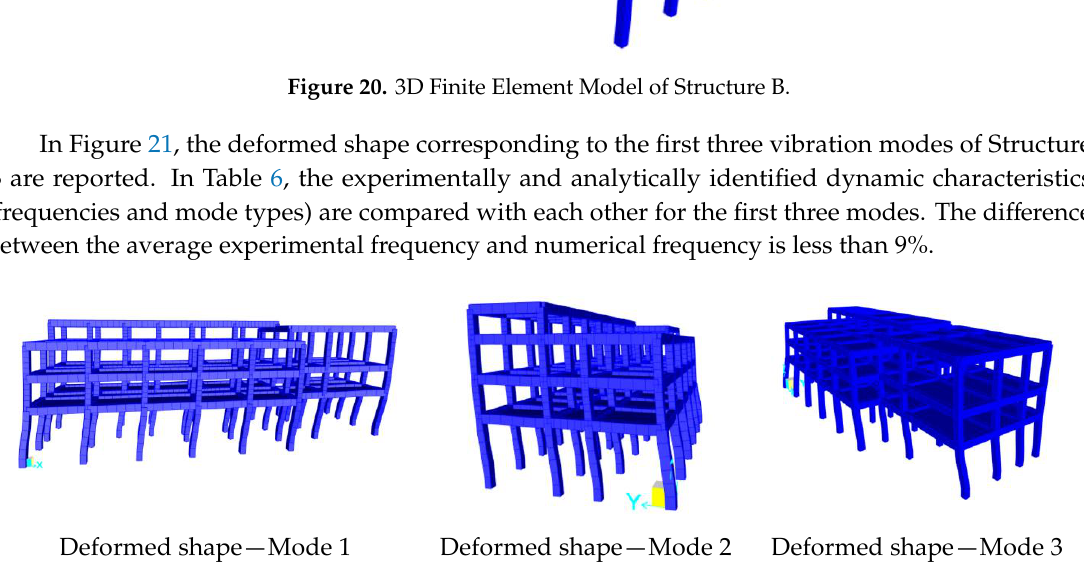
Figure 21. Modes of vibration of the FE model of Structure B. Table 6. Numerical frequencies (f) and mode shape types obtained from the FE model—Structure